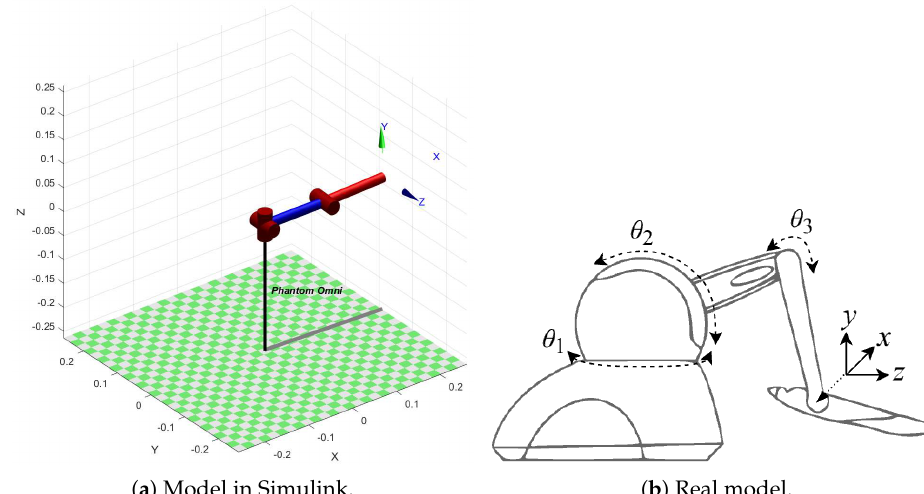
Figure 4. Tactile platform slave